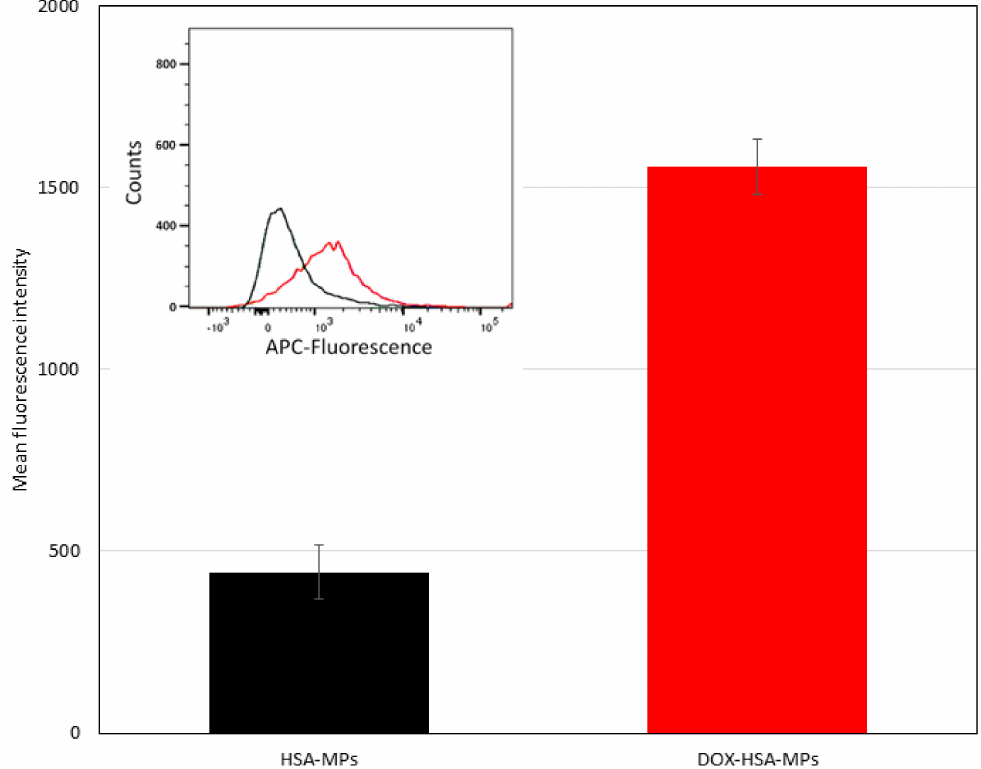
Figure 6. Mean fluorescent intensity (MFI) of HSA-MPs and DOX-HSA-MPs in the Allophycocyanin (APC) channel. Insert: Flow cytometry histograms showing the APC-fluorescence intensity distribution of the two types of particles (black line—HSA-MPs; red line—DOX-HSA-MPs in